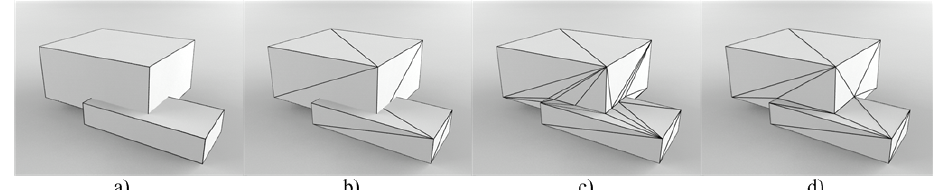
Figure 2. Tessellation and decomposition of intersecting objects (a) the input model; b) tessellated result; c) decomposition using triangle-triangle intersection; d) refined result by merging coplanar triangles)